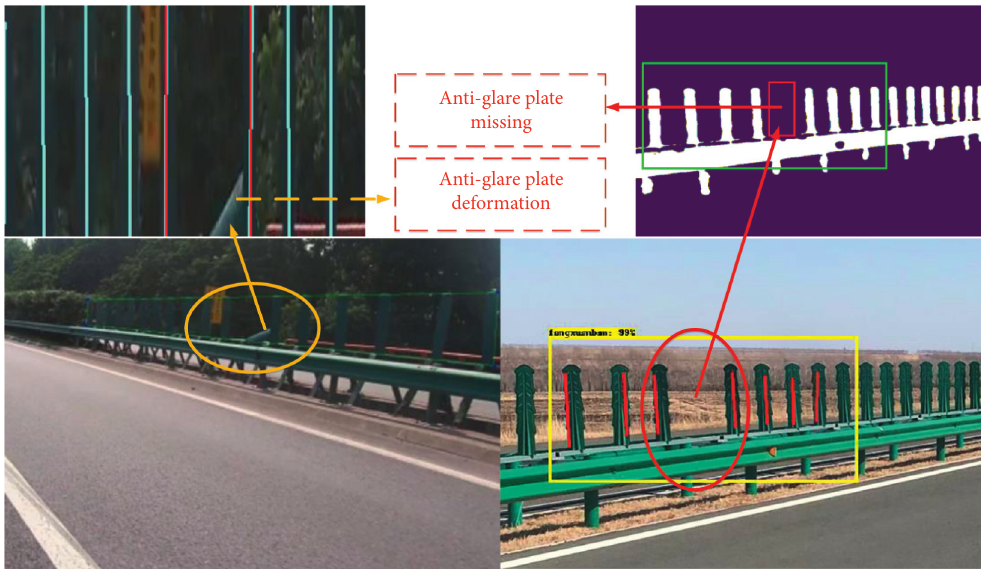
Figure 11: Identification of the anti-glare plate missing and